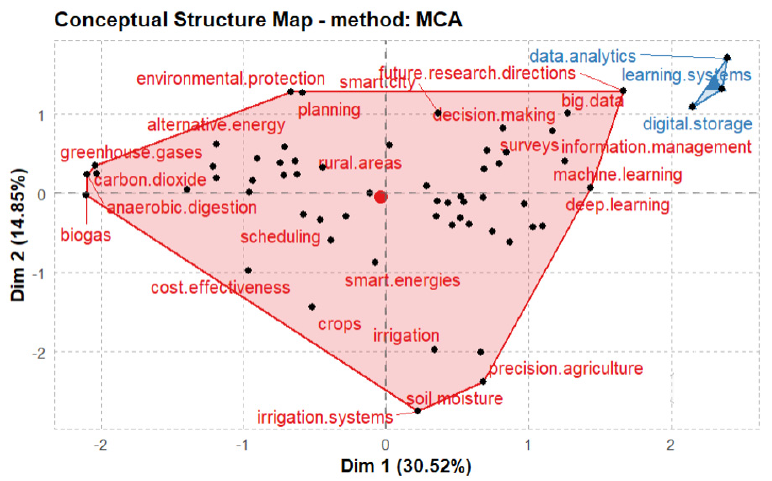
Figure 11. Factorial analysis based on MCA method. Source: Scopus-Biblioshiny.